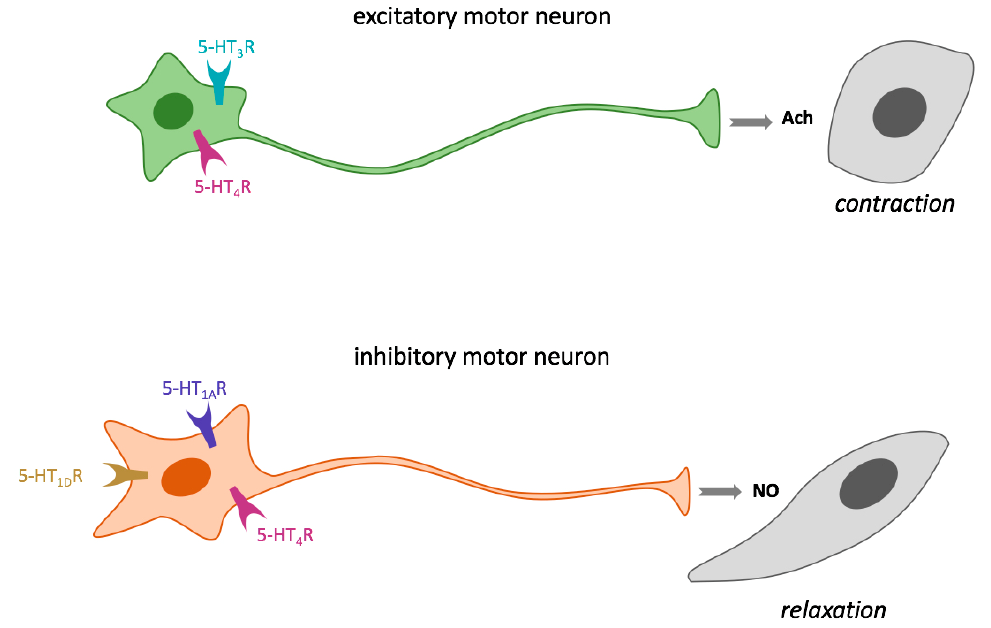
Figure 4. Regulation of GIT smooth muscle contraction and relaxation through 5-HT receptors. AcH, acetylcholine; 5-HT 1A R serotonin receptor type 1A; 5-HT 1D R; serotonin receptor type 1D, 5-HT 3 R; serotonin receptor type 3, 5-HT 4 R; serotonin receptor type 4.